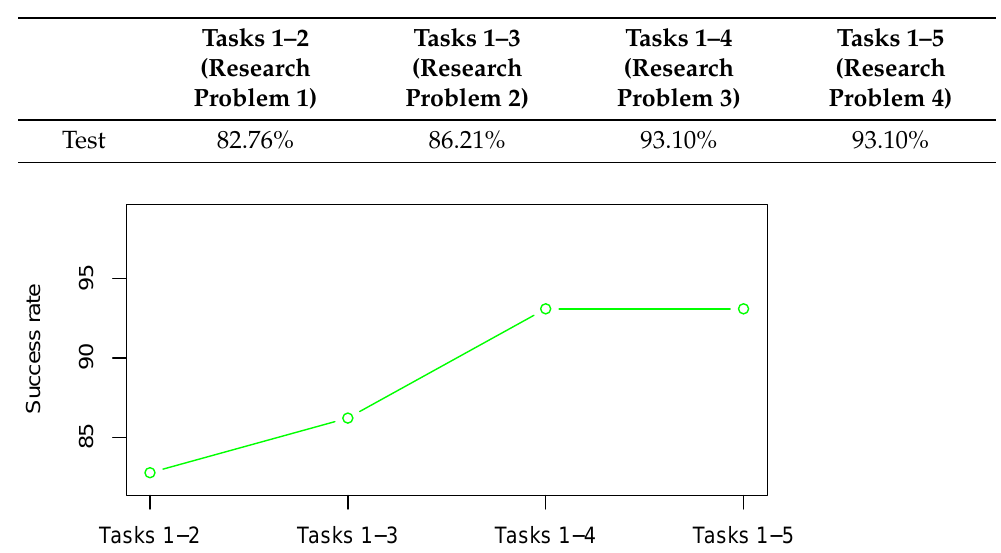
Table 2. Success rates for the supervised classification of average grade intervals over 6 tasks for the test data on the model constructed using the training data. Test data refer to the n = 29 groups in the academic course 2020/21 and training data to the m = 50 groups along the academic courses 2017/18, 2018/19, and 2019/20. The analysis is based on: Tasks 1 and 2 (left column), Tasks 1, 2, and 3 (second left column), Tasks 1, 2, 3, and 4 (third left column) and Tasks 1, 2, 3, 4, and 5 (right column). For the success rate, it is used as correctly classified only the groups of students whose average grade is displayed in blue in Table 1.